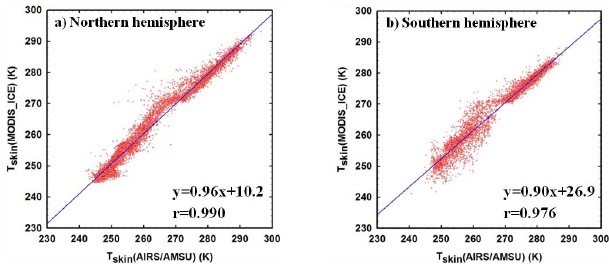
Fig. A3. Scatter diagrams for the 9-day composite of T skin (MODIS_ICE) versus T skin (AIRS/AMSU) over the (a) Northern Hemisphere during the days 106–114, 2003, and (b) Southern Hemisphere during the days 258–266, 2003. The values of AIRS/AMSU and MODIS have been compared to each other in a 1 ◦ × 1 ◦ grid